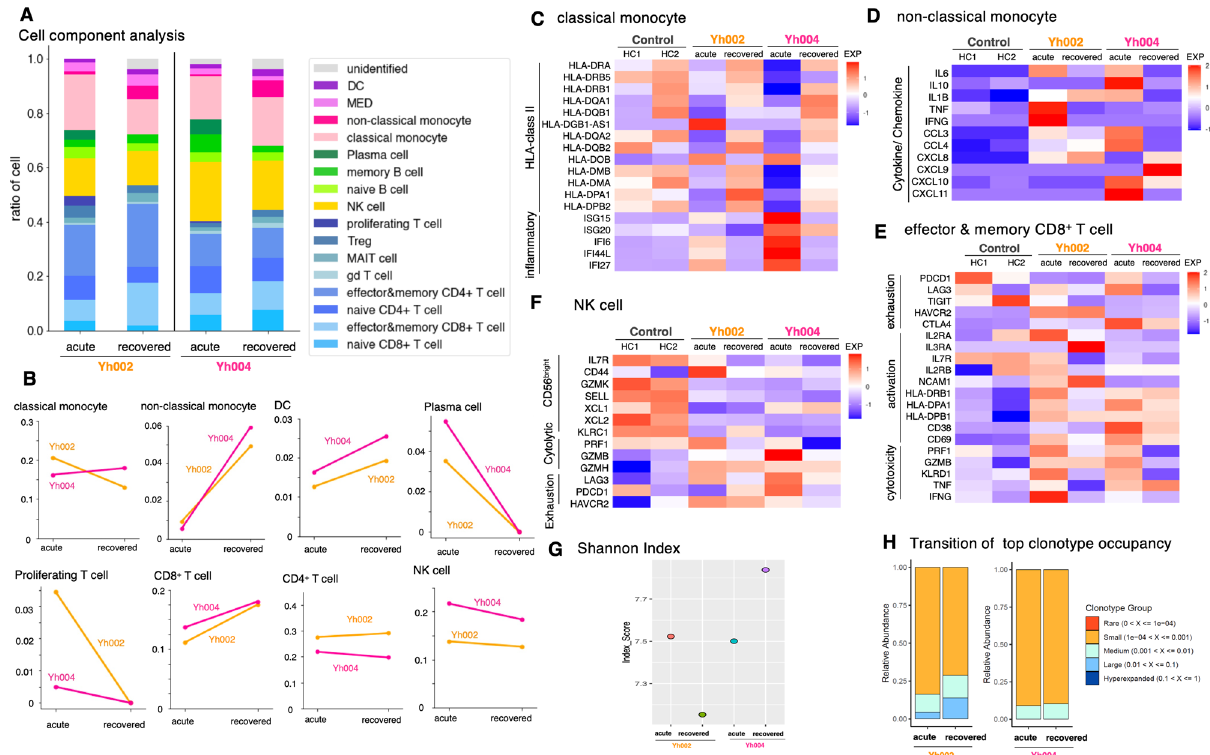
Figure 5. Longitudinal single-cell analysis of Yh002 (severe) and Yh004 (critical). (A) Cell proportion of each case. Bar plot shows cell type included in each dataset in Yh002 and Yh004. Color key is shown in the margin. (B) Cell proportion transition of Yh002 and Yh004 in classical monocyte, non-classical monocyte, DC, plasma cell (top, from left to right), proliferating T cell, CD8 + T cell, CD4 + T cell, and NK cell (bottom, from left to right). (C–F) Expression level of classical monocyte (C), non-classical monocyte (D) , effector and memory CD8 + T cell (E) , and NK cell (F) . (G, H) TCR diversity transition of Yh002 and Yh004. The y-axis shows the Shannon index of those patients at disease onset and after recovery from the SARS-CoV-2 infection (G) and clonotype group component (H)